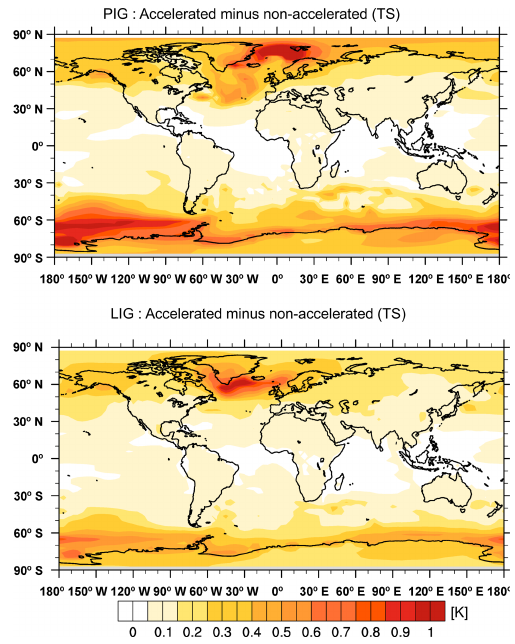
Figure 12. Root mean square difference between accelerated and non-accelerated simulations for surface temperature (TS). All plots were created using the decadal mean values (referring to model years). Ten-point bins are used for the non-accelerated run to have the same number of data points on the time axis as in the accelerated simulation. An additional 1000-orbital-year filter has been applied to both accelerated and non-accelerated time series to remove noise. Due to these low-pass filtering only the long-term (orbital-forced) trend variability is considered by the root mean square